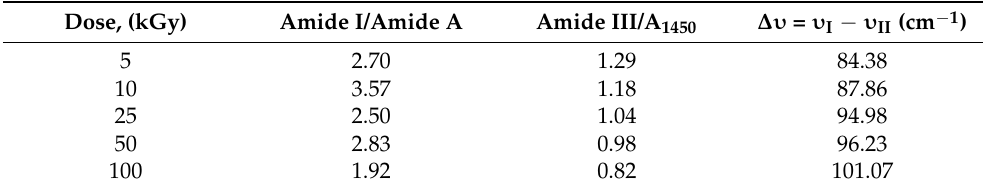
Table 2. FTIR characteristics of e-beam crosslinked collagen hydrogel at different doses. Dose,